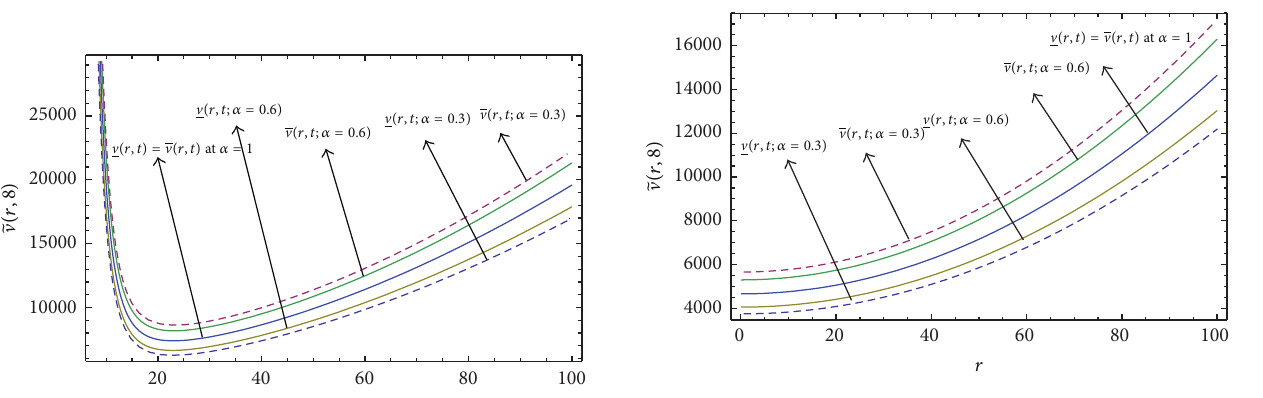
Figure 14: Interval solution of Case 4 at 𝑡 = 8